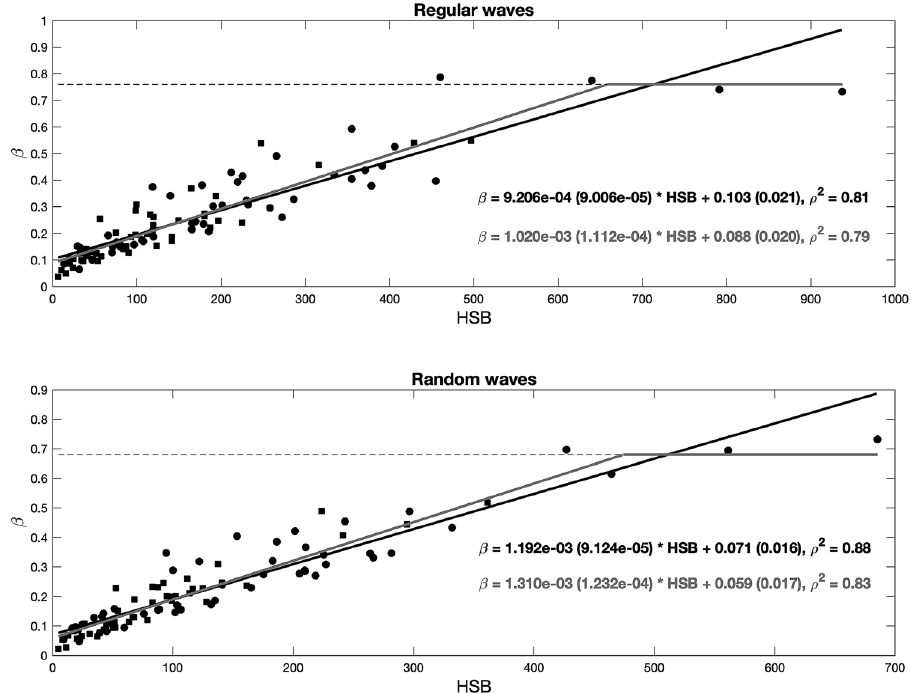
Figure 6. Wave damping coefficient, β , as a function of the hydraulic standing biomass, HSB , under all regular (top panel) and random (bottom panel) wave conditions. Both panels show linear fitting results obtained without considering the saturation point, indicated by the black solid line, and those obtained considering the saturation point, indicated by the gray solid line. The black dashed line indicates the saturation point. 95% confidence interval is shown in brackets and correlation coefficient ( ρ 2 ) for each fit is also